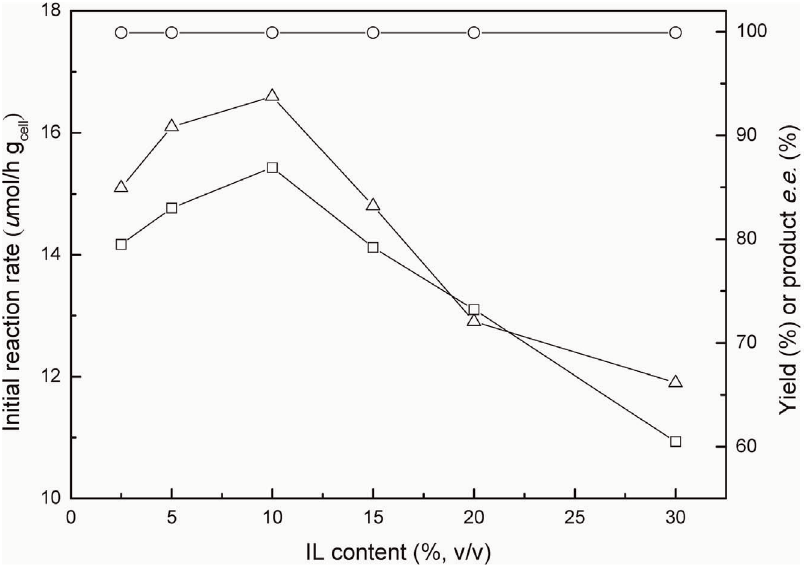
Figure 3. Effect of C 2 OHMIM ? NO 3 content on the bioreduction of TMSB. Symbols: ( g ) the initial reaction rate; ( % ) the maximum product yield; ( # ) the product e.e. All products have the ( S ) configuration. Reaction conditions: 3.0 mmol/L TMSB, 4.0 mL TEA-HCl buffer (100 mmol/L, pH 5.0)